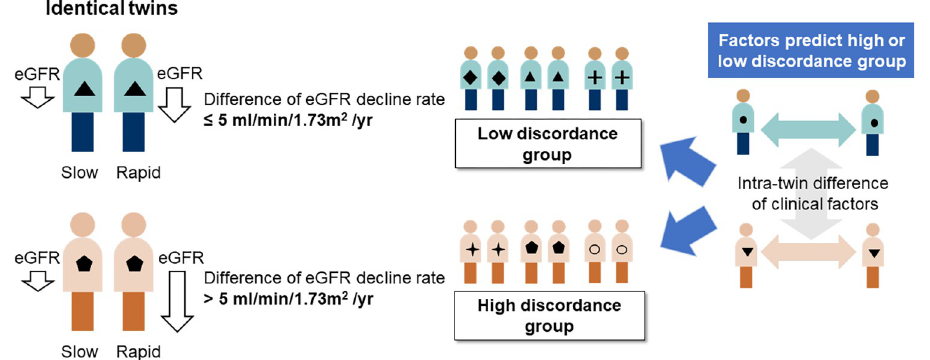
Fig 2. Schematic flow for study group classification and